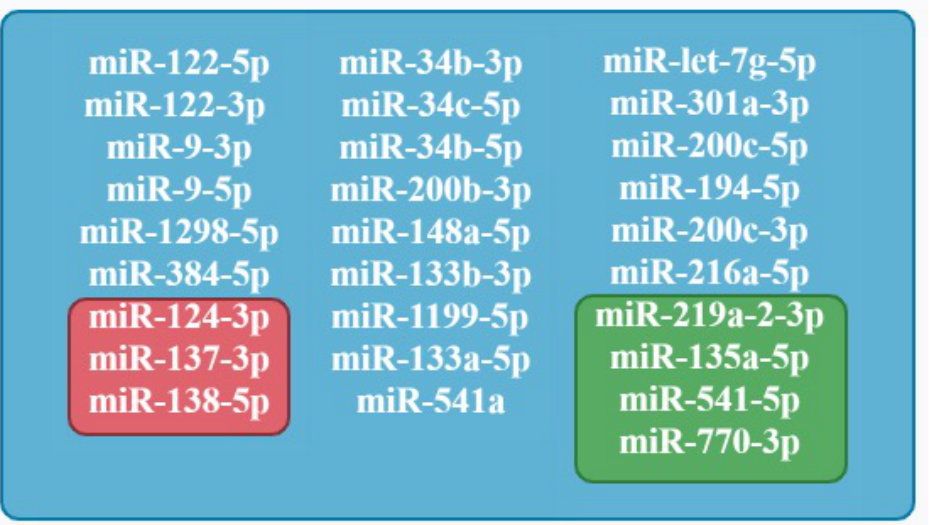
Figure 5. Comparative analysis of dysregulated serum miRNAs after ICH in aged mice (blue square) with human-brain-enriched miRNAs (red square) and dysregulated plasma miRNAs after ICH in young rats (green square). The serum microRNAs, which are human-brain-specific and differentially regulated in the plasma of young mice after ICH, are